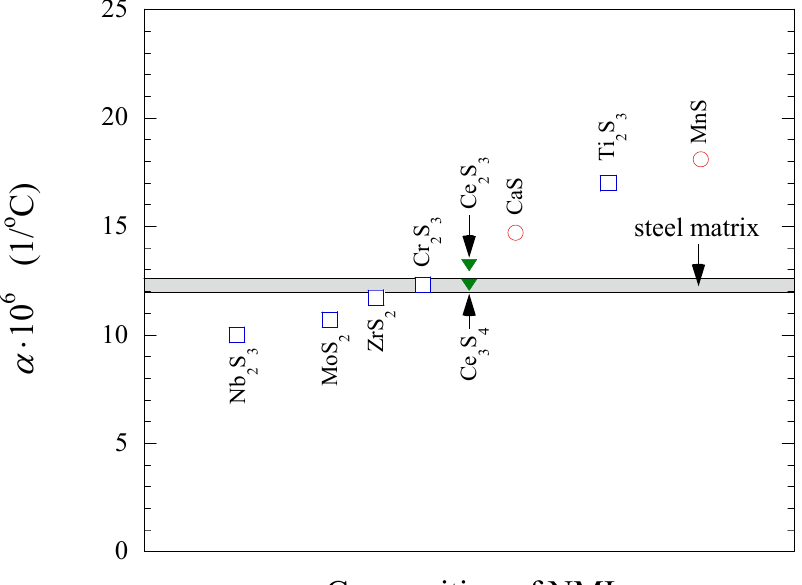
Figure 11. Thermal expansion coefficients, α , for some sulfides in comparison to the steel matrix. of point marks: red circle—[18], blue square—[21], green filled